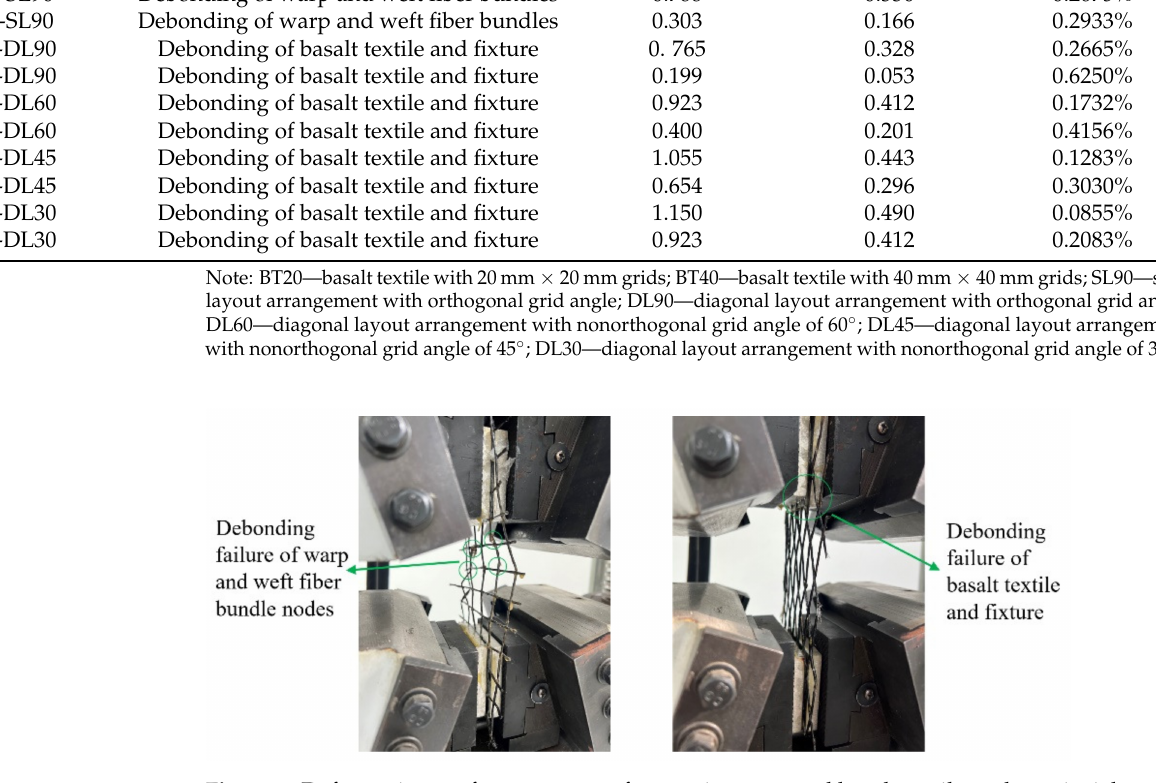
Figure 1. Deformation performance test of epoxy-impregnated basalt textile under uniaxial tensile test. Debonding failure of warp and weft fiber bundle nodes ( left ); debonding failure of basalt textile and fixture ( right